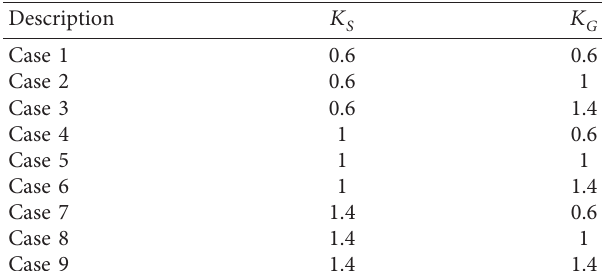
Table 3: Parameters corresponding to different working conditions.